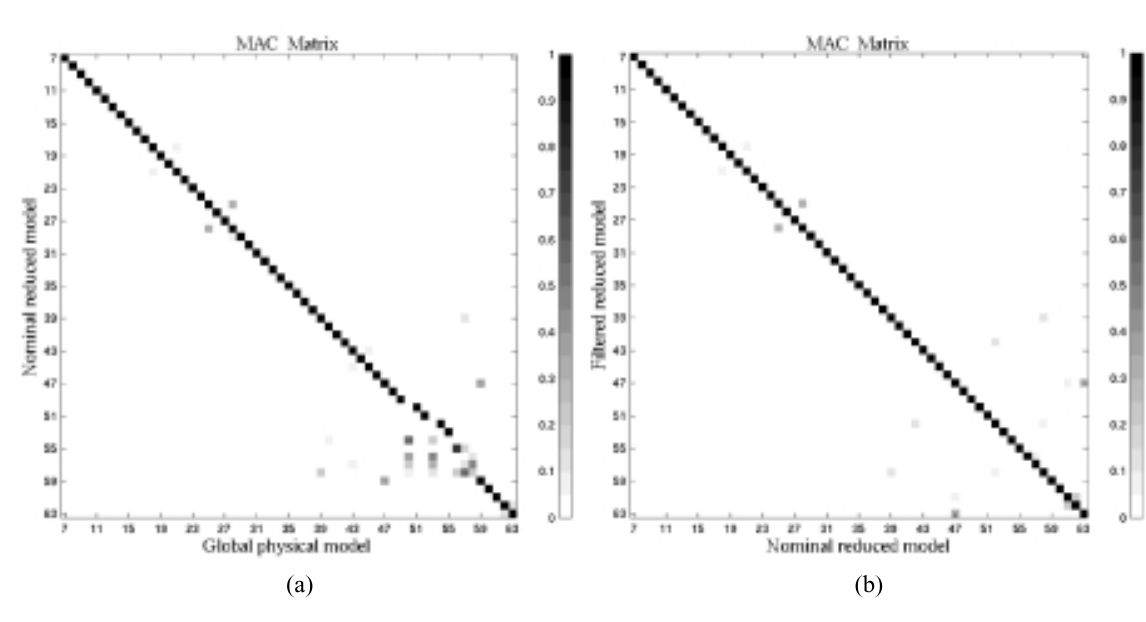
Fig. 8. Improved superelement error localization.